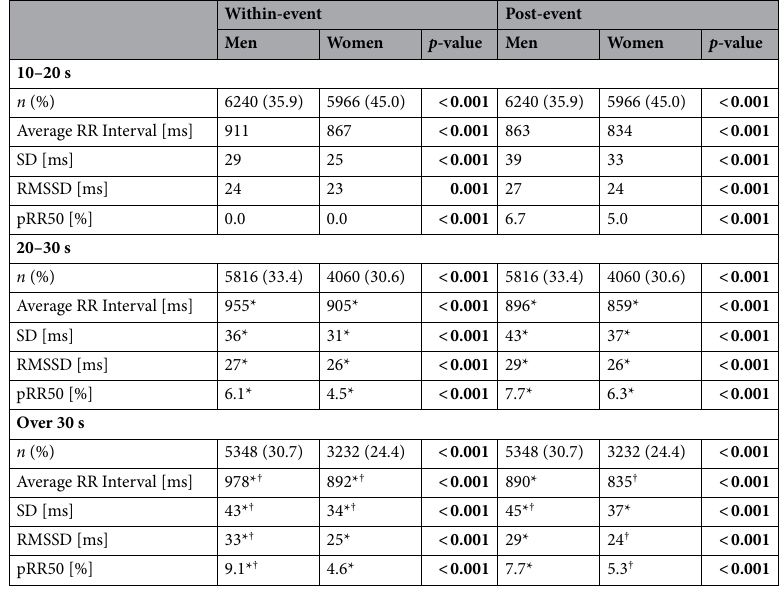
Table 3. Within- and post-event time-domain HRV parameter values in different hypopnea duration groups for men and women. Medians of parameters were calculated from electrocardiogram recorded during hypopnea events (within-event) and within a 15-s segment following the hypopnea event (post-event). The p -values presented in the table denote the statistical significance of the differences between men and women; p -values indicating statistically significant differences ( p < 0.01) are bolded. The statistical significance of the difference in parameter values between men and women and between hypopnea duration groups were assessed by using the Mann–Whitney U test. HRV heart rate variability, n the number of hypopneas, SD standard deviation of RR intervals, RMSSD root mean square of successive differences, pRR50 the number of adjacent RR intervals differing more than 50 ms divided by the total number of RR intervals during the hypopnea. *Statistically significant difference ( p < 0.01) compared to the 10–20 s hypopneas. † Statistically significant difference ( p < 0.01) compared to the 20–30 s hypopneas.